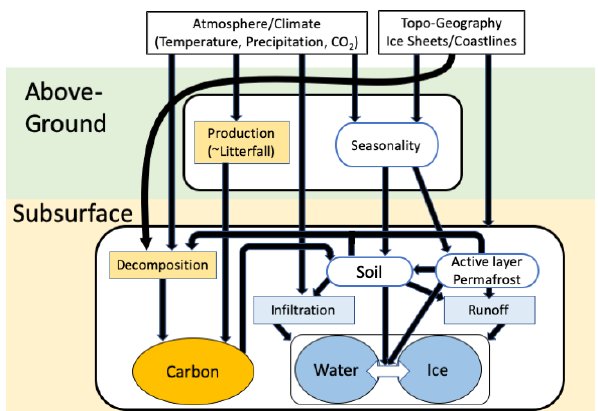
Figure 1. Schematic of the SOC-ICE-v1.0 numerical model to cal- culate soil organic carbon (SOC) and ground ice (ICE)